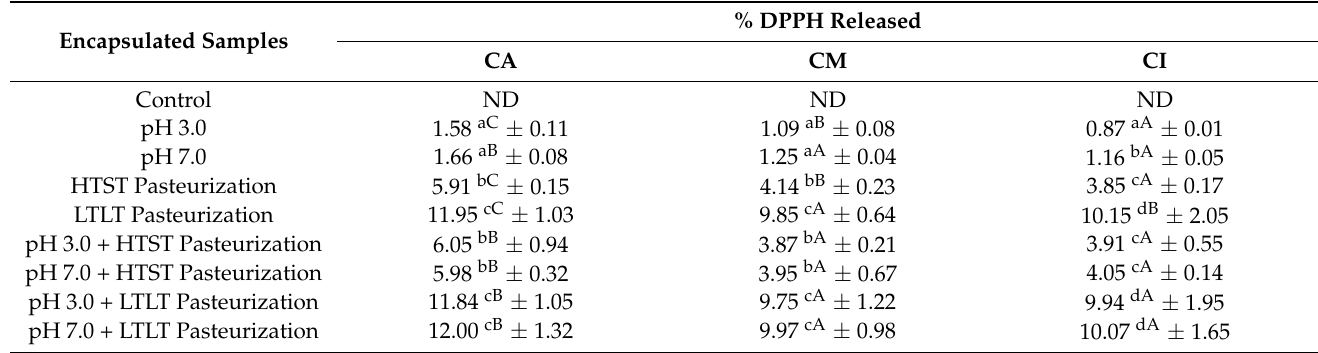
Table 6. % DPPH release of alginate, alginate/maltodextrin, and alginate/inulin hydrogel beads con- taining encapsulated antioxidant crude extract from CSCG after simulated food process